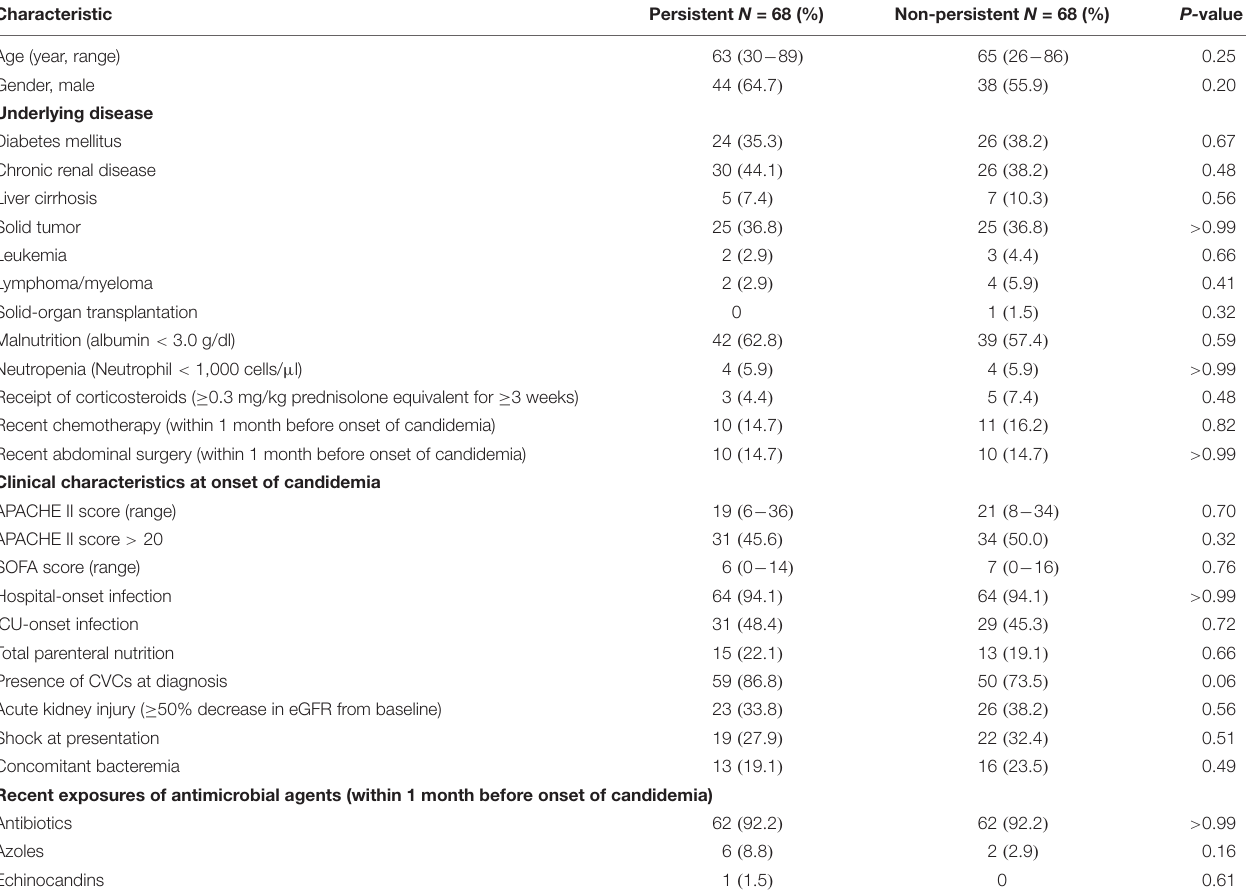
TABLE 1 | Characteristics of the 136 adult patients with persistent and non-persistent candidemia after propensity-score matching.